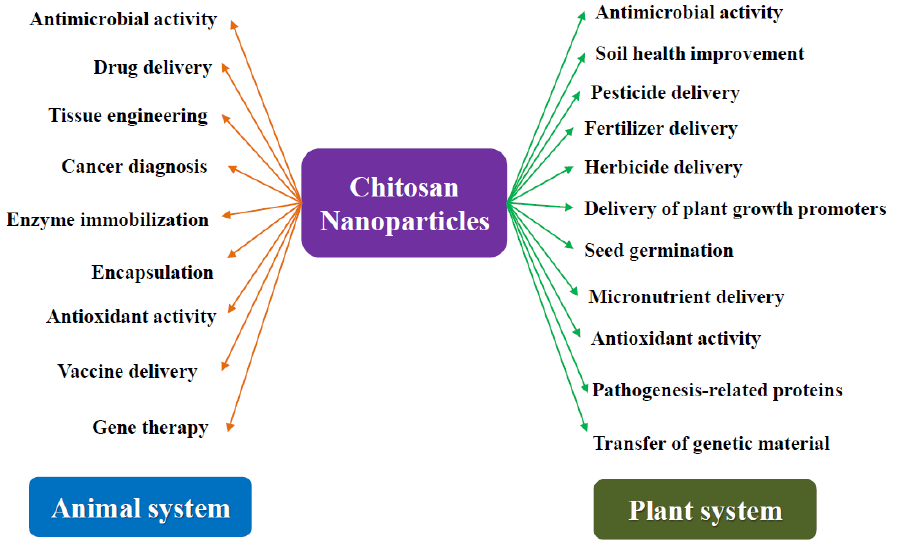
Figure 2. Applications of chitosan nanoparticles.